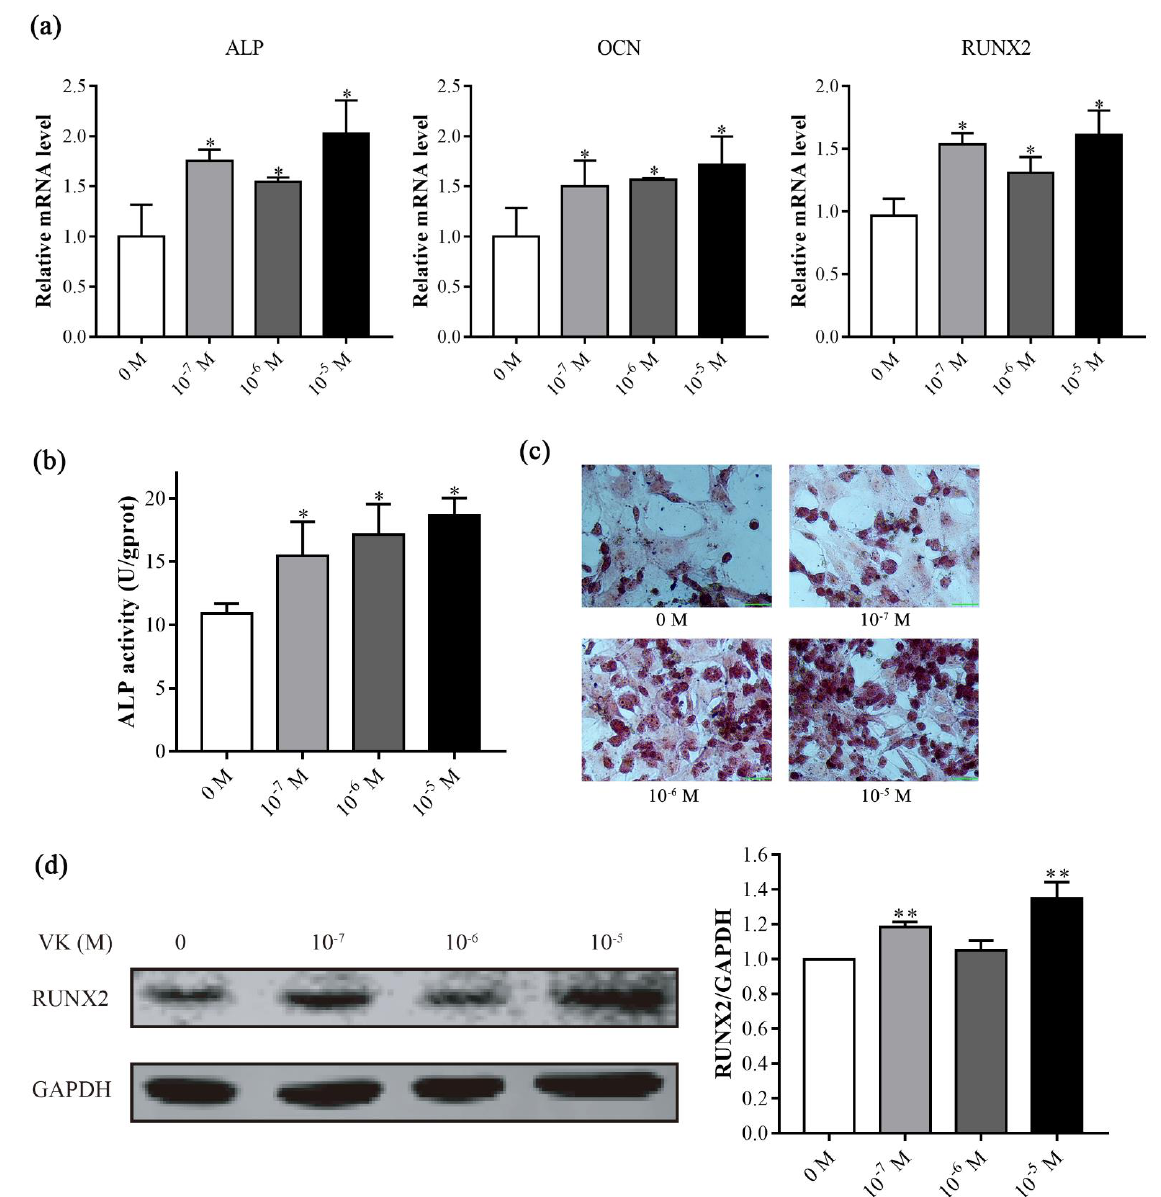
Figure 2. VK 2 promoted osteogenesis in C3H10 T1/2 clone 8 cells in vitro. ( a ) The mRNA levels of ALP, OCN, and RUNX2 were detected after VK 2 treatment for 7 days. ( b , c ) The effect of VK 2 on ALP during osteoblastogenesis, as determined by ALP activity ( b ) and ALP staining ( c ). ( d ) The protein level of RUNX2 after VK 2 treatment for 7 days. The data are presented as the mean ± SEM; *, ** denotes a significant difference with respect to the control group ( p < 0.05).